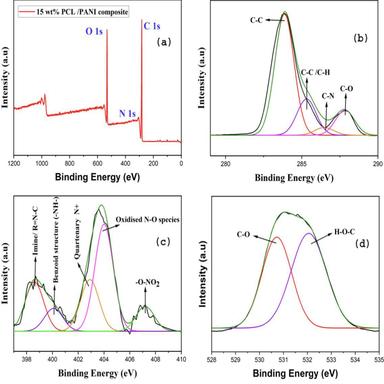
XPS spectra of 15 wt% PCL/PANI composite (a) XPS survey scan of 15 wt% PCL/PANI composite (b) C 1 s region (c) N 1 s region (d) O 1 s region of the sample.